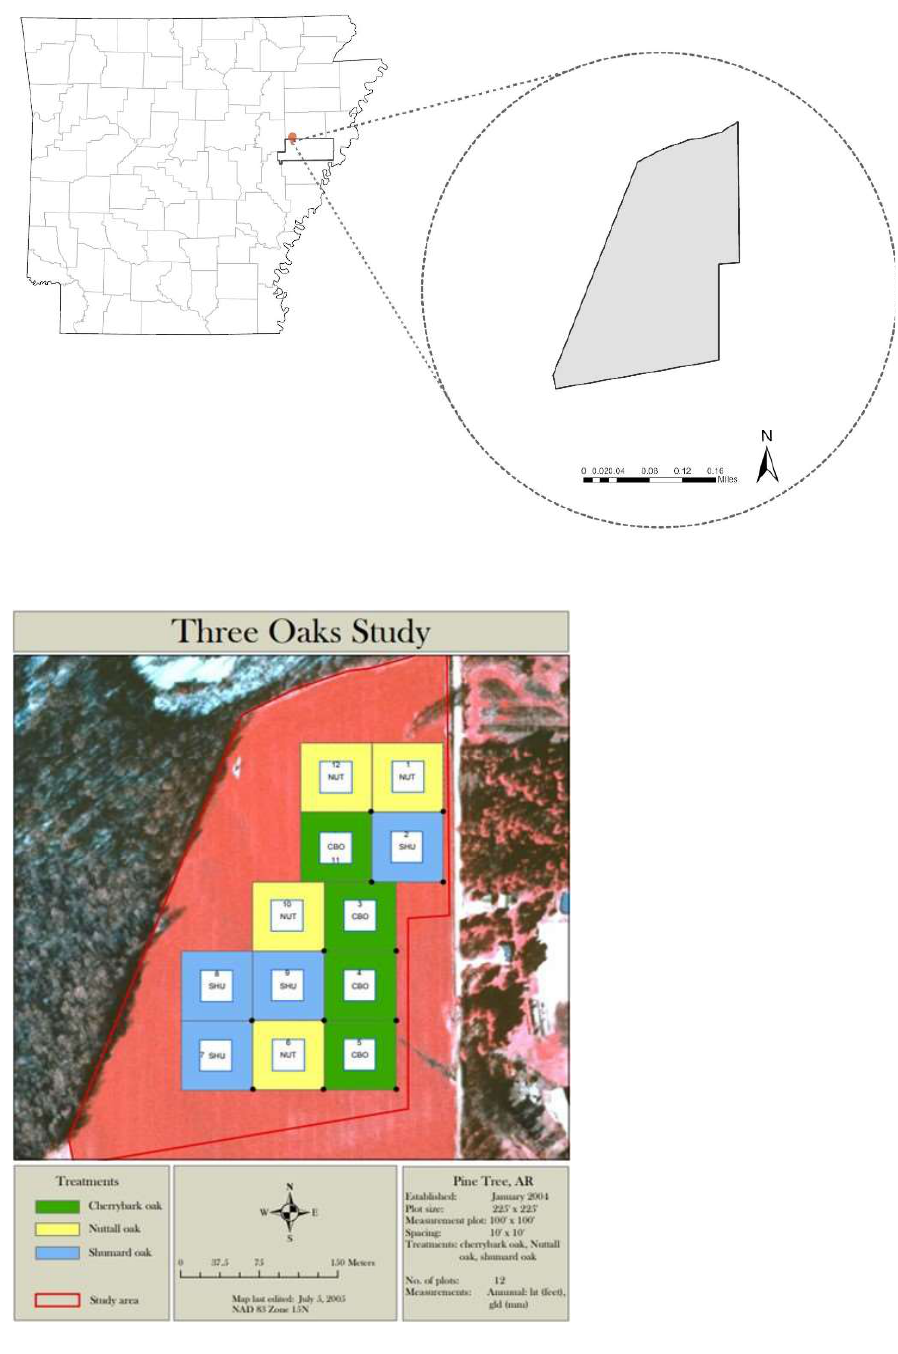
Figure 1. The plantation area and project site (left) as well as the layout (right) of the measurement plots within the study area with all three oak species (CBO—Cherry bark oak, NUT—Nuttall oak, SHU—Shumard oak) located in the Division of Agriculture Pine Tree Research Station (AgPTRS) in the Arkansas Delta.